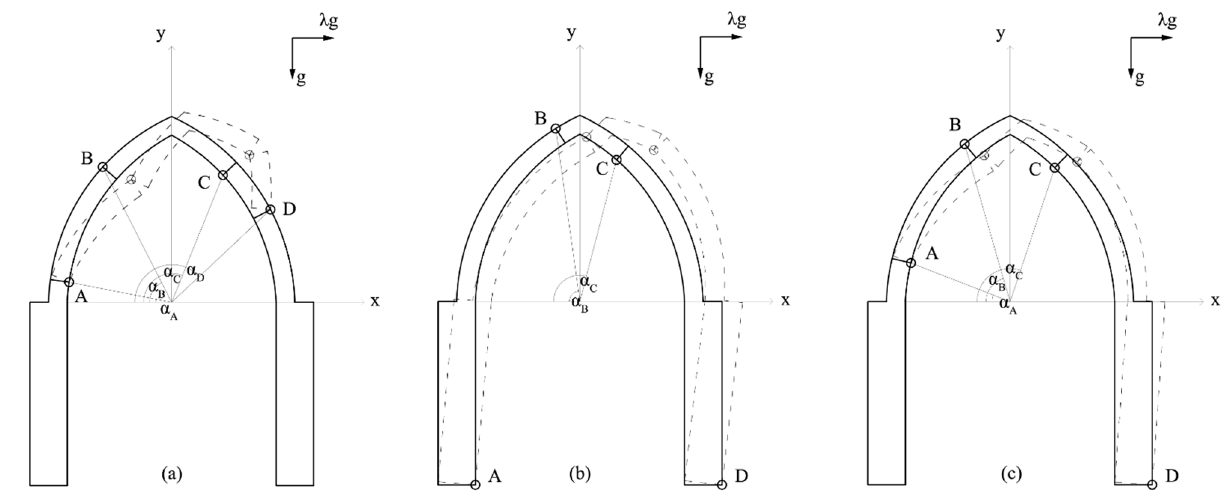
Figure 1. Collapse mechanisms of a buttressed arch: ( a ) Local mechanism; ( b ) Global mechanism; ( c ) Semi-global mecha- nism.